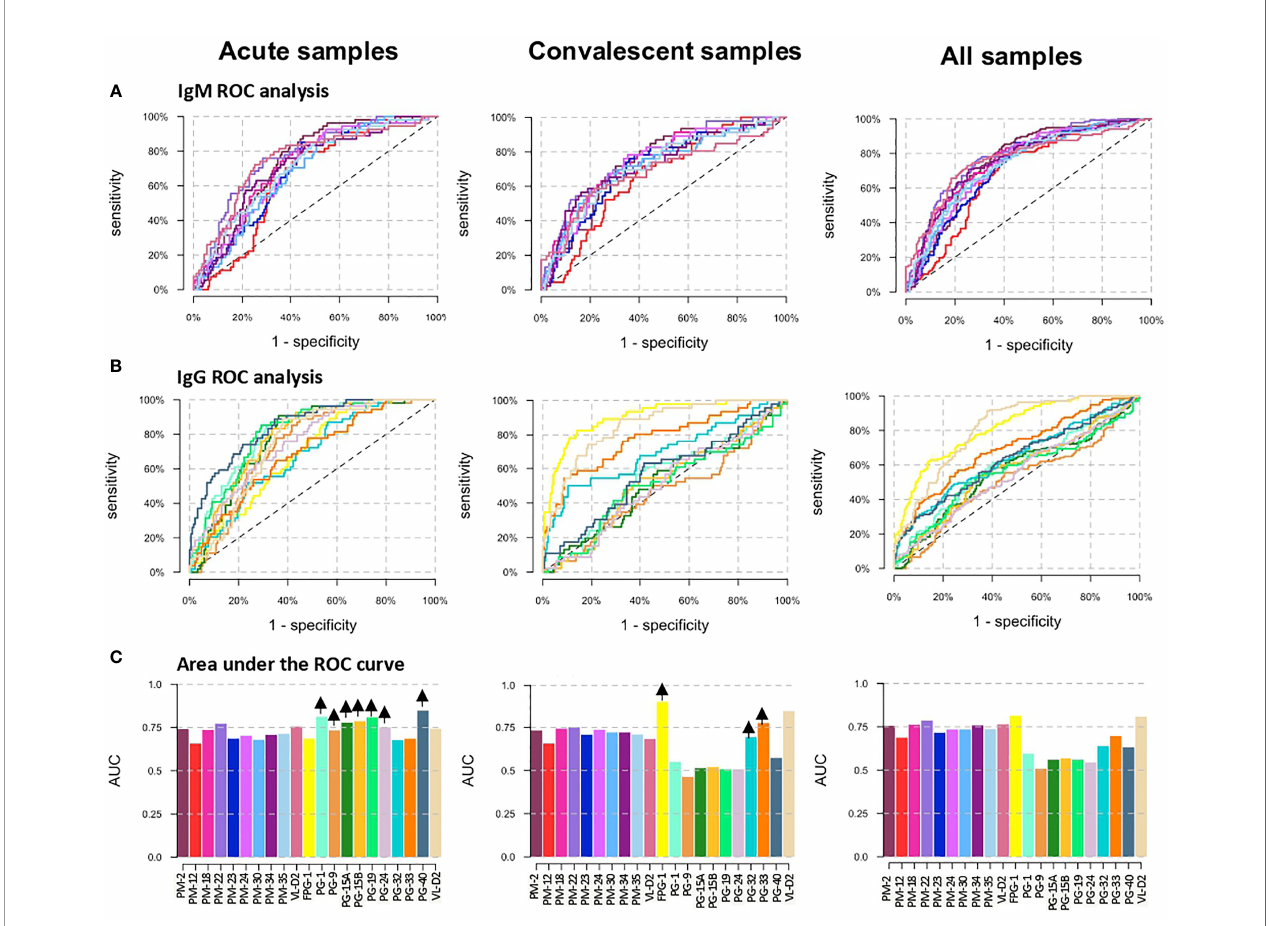
FIGURE 3 | Diagnostic performance of the peptide biomarkers. (A) ROC curves for IgM peptides and (B) IgG peptides. The three columns correspond to the separate analysis of the data considering as positive DENV samples: acute samples only (left graphs), convalescent samples only (center graphs) and acute + convalescent (right graphs). Colors correspond to Abs against the different antigens as shown in panel (C) . (C) Area under the ROC curve (AUC) for individual biomarkers. Arrows in the top of each bar indicates an increase in the AUC of the peptide when only acute DENV or convalescent DENV samples are included as positive controls in the